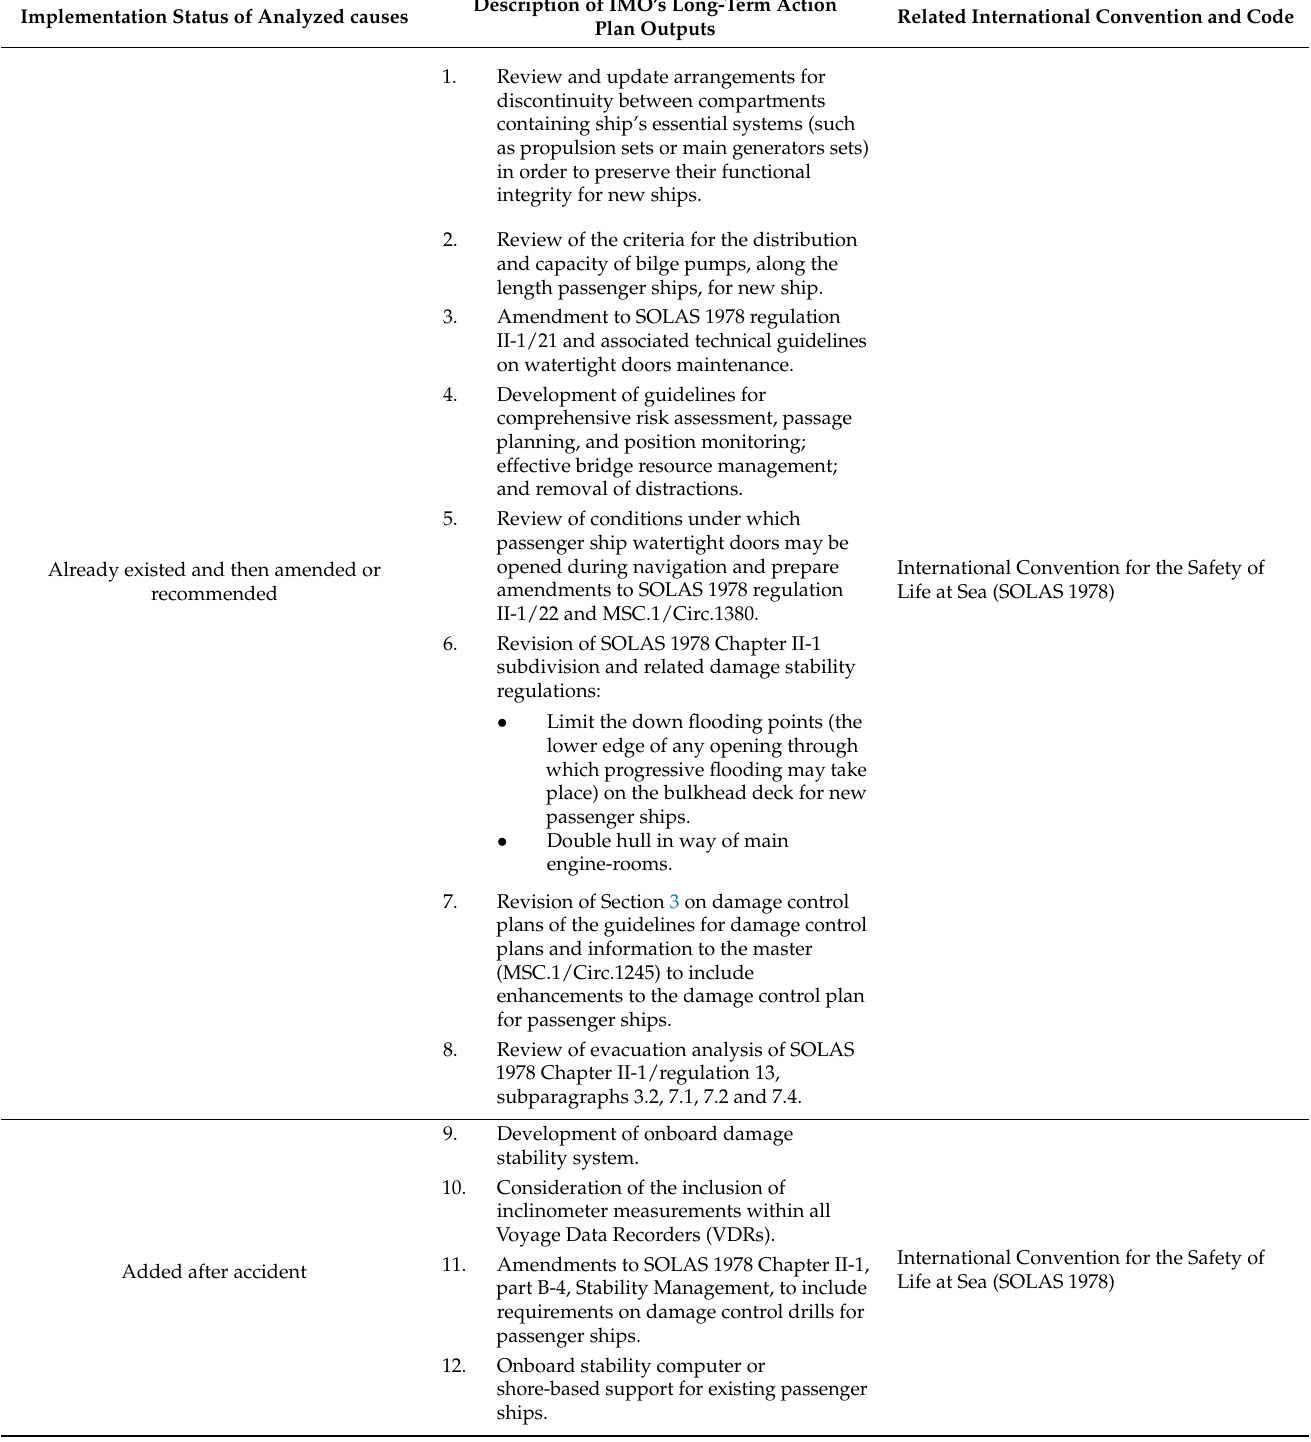
Table 2. Long-term action plan of the IMO after the Costa Concordia